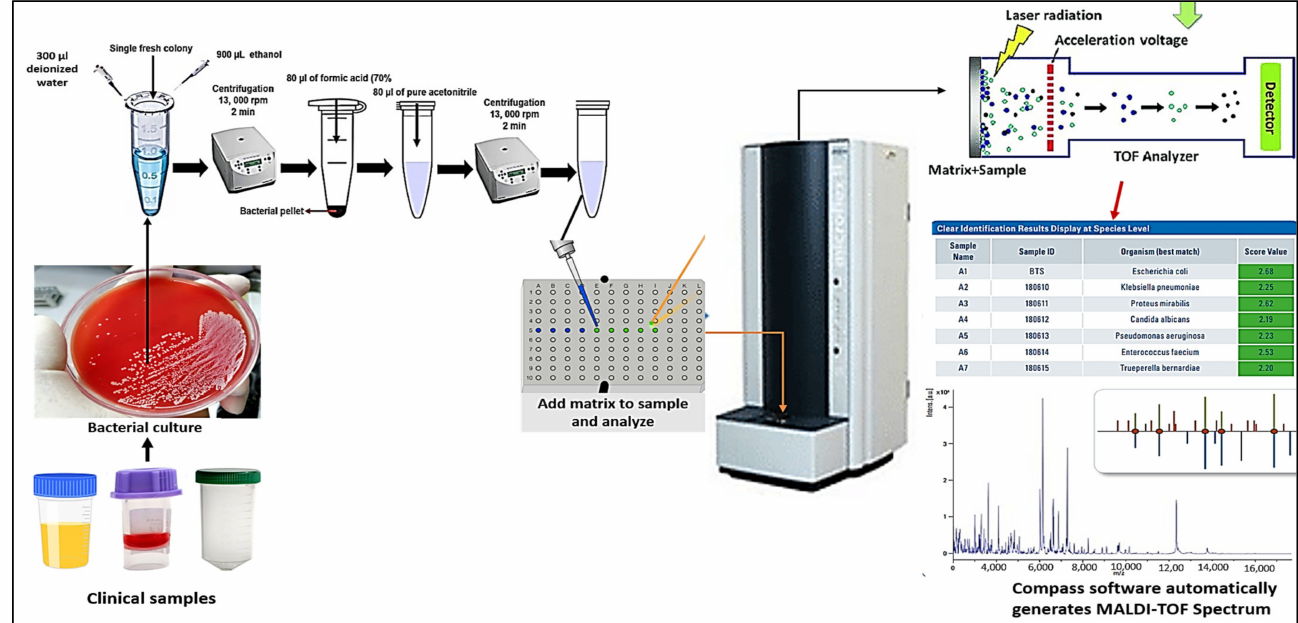
Figure 1. The workflow of MBT for identifying various microorganisms. The fresh colony is placed on a MALDI target plate that will be beamed in order for it to be identified by MS. The target plate is put into the device once the MALDI matrix has been added and processed with the unknown sample. The mass/charge ratio ( m / z ) of the constituent proteins is determined by the time of flight to the detector and the intensity of the signal. To ionize the ribosomal proteins molecules, the device irradiates the target plate with a laser. To identify the sample, the acquired MALDI mass spectral fingerprint is compared with the stored